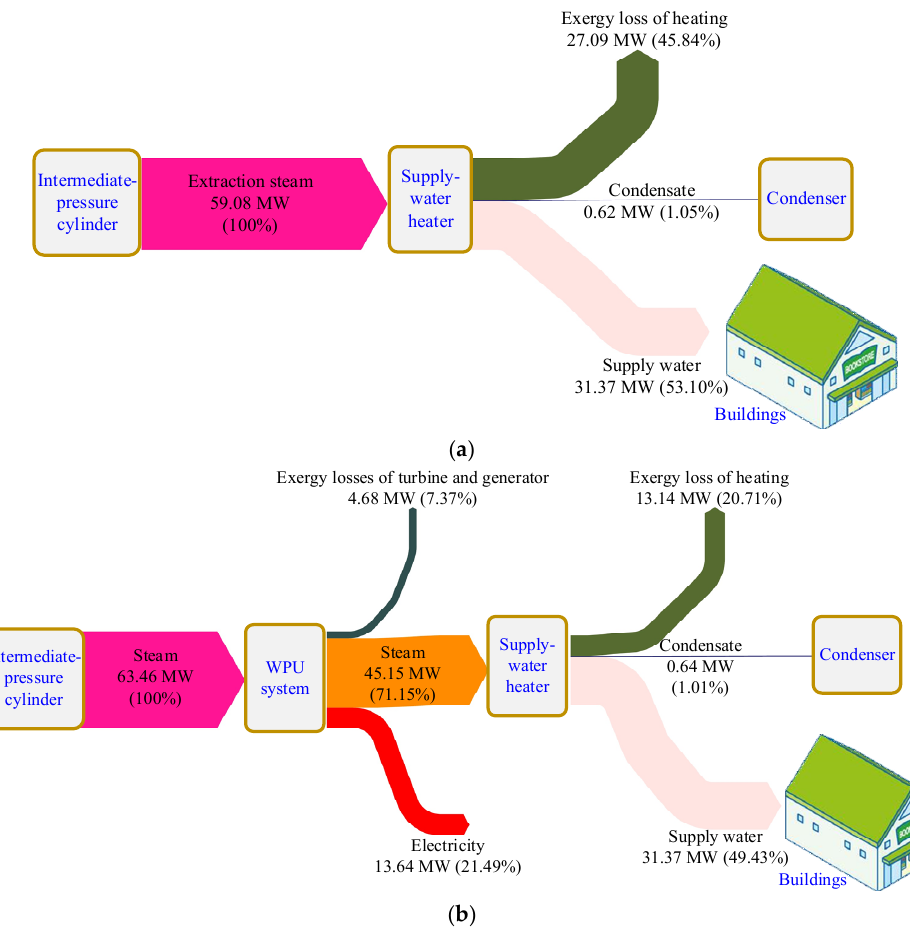
Figure 7. Exergy flow diagrams of the original and the proposed heating processes. ( a ) Original heating process; ( b ) proposed heating process. MW—heat.